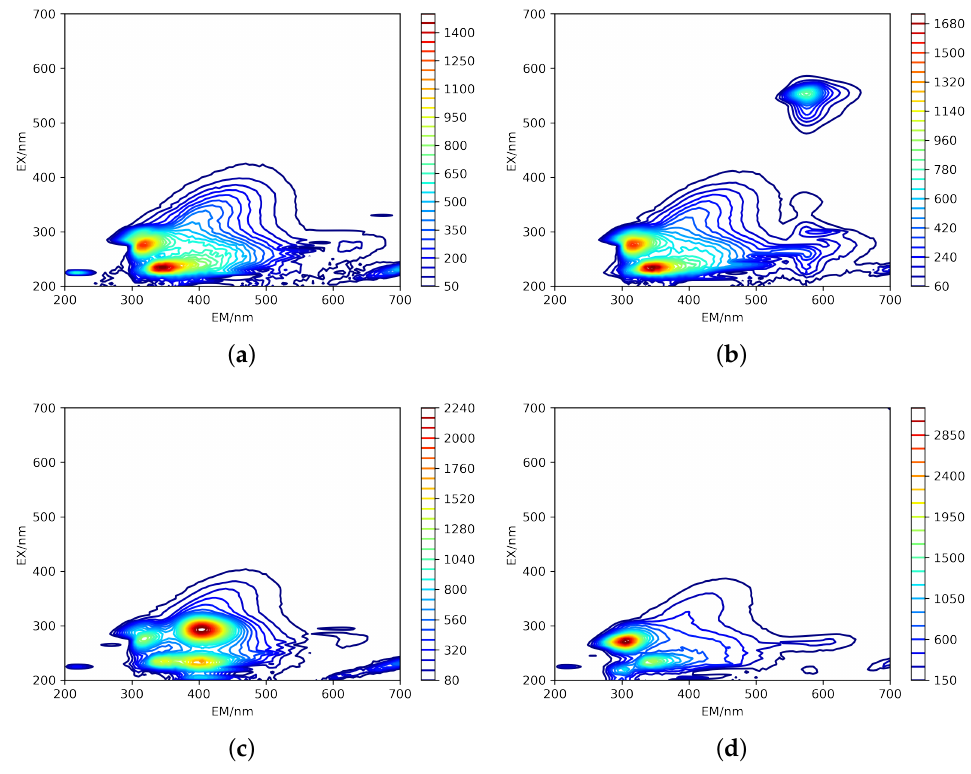
Figure 3. Preprocessed spectra: ( a ) drinking water spectrum; ( b ) 20 µ g/L rhodamine B spectrum; ( c ) 20 µ g/L salicylic acid spectrum; ( d ) 20 µ g/L phenol